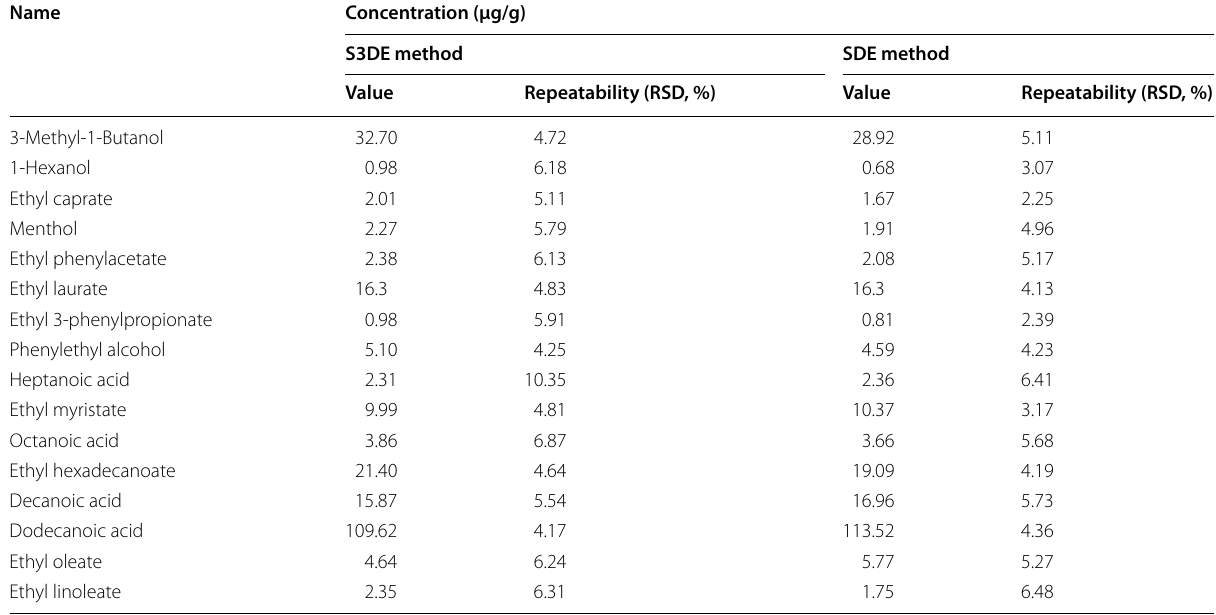
Table 3 Concentrations of volatile compound in jujube extract obtained by the S3DE method and the SDE